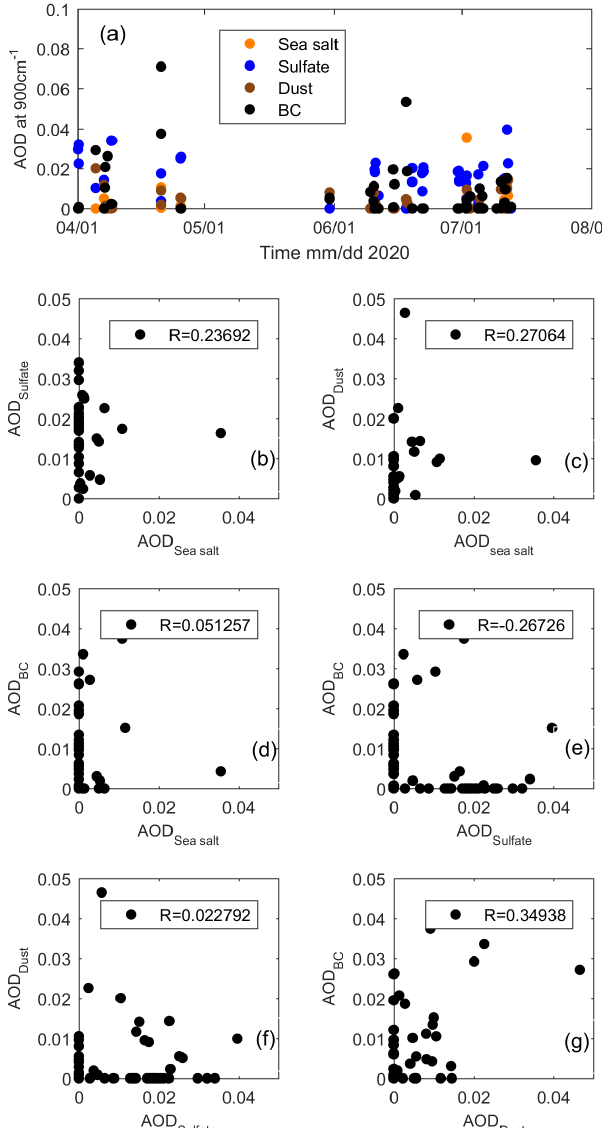
Figure 9. (a) Long-term observations using FTS (from April to Au- gust). The correlations between (b) sea salt and sulfate, (c) sea salt and dust, (d) sea salt and BC, (e) sulfate and BC, (f) sulfate and dust, and (g) dust and